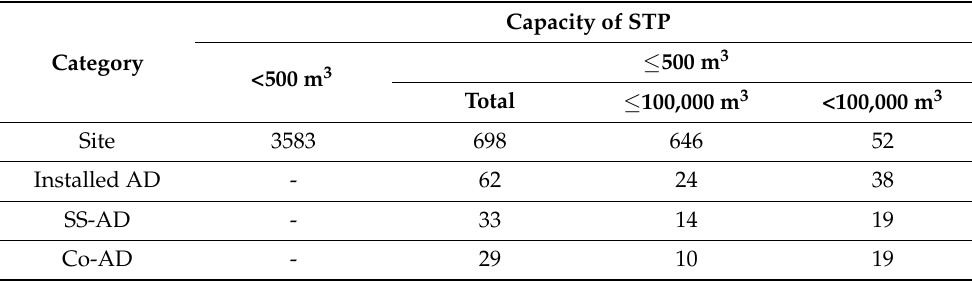
Table 1. Analyzed STP group by the capacity of STP. This table shows the number of analysis targets by capacity and the installation status and operation method of AD. Capacity of STP Category <500 m